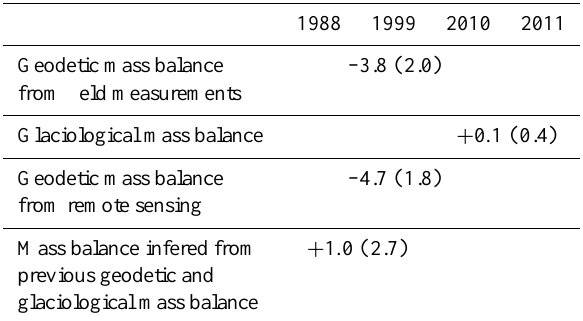
Table 7. Combination of geodetic and glaciological mass